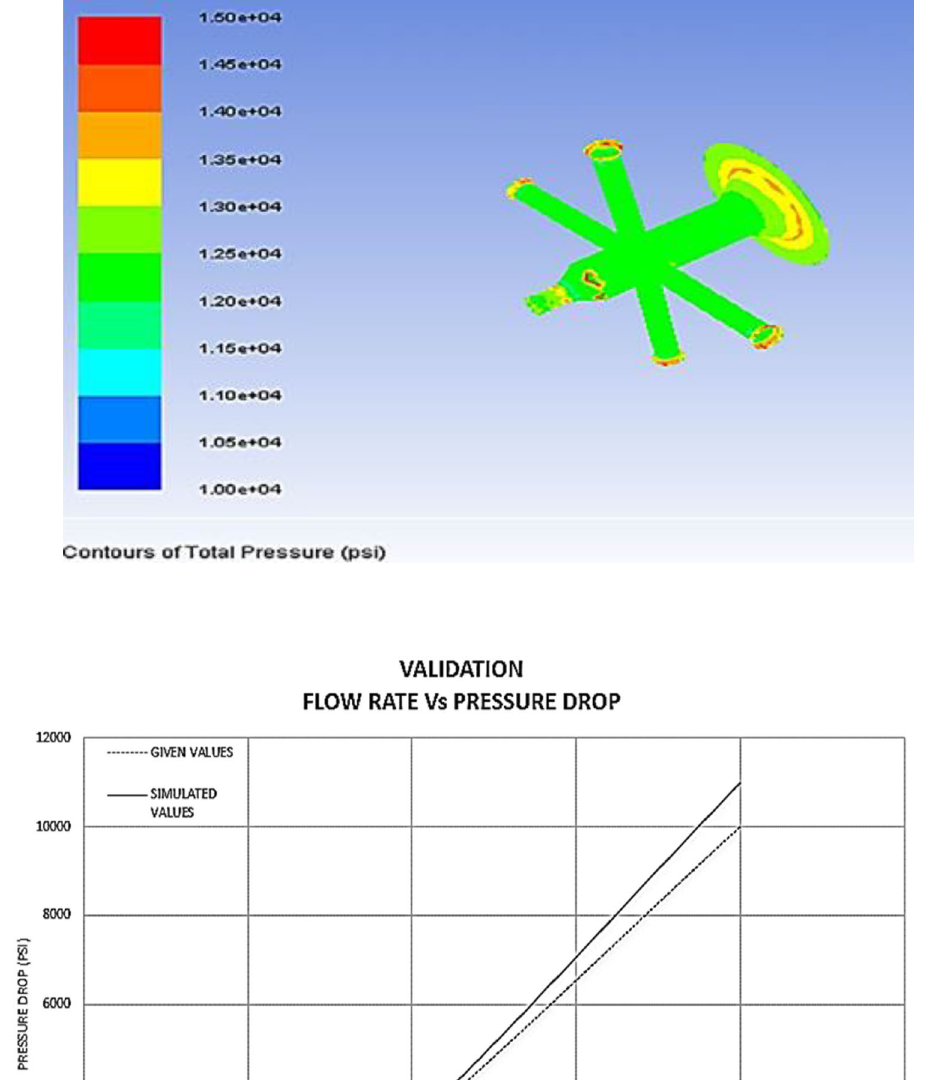
Fig. 6 Pressure contour for the